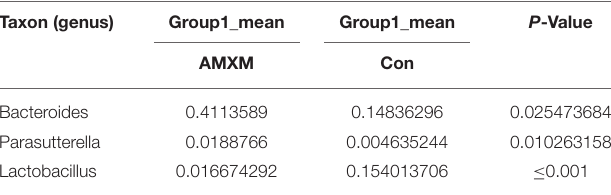
TABLE 7 | Based on Metastats analysis for flora differences between AMXM and Con groups under the genus. Taxon (genus)